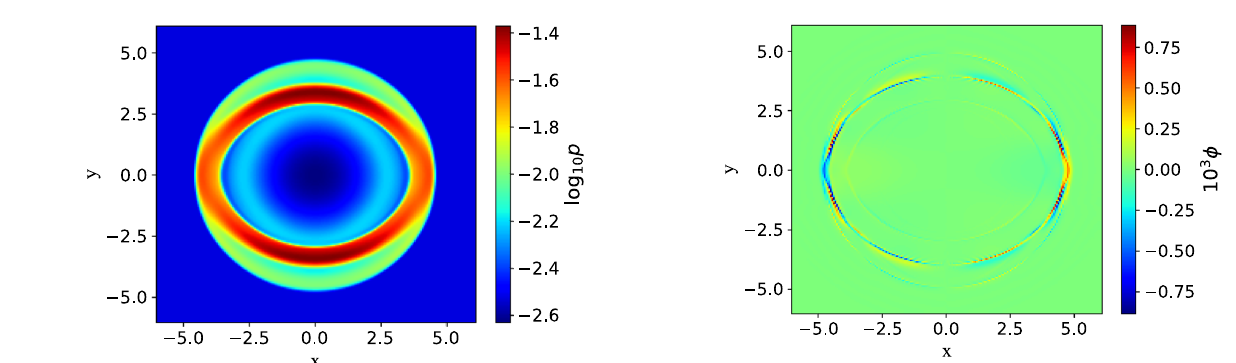
Fig. 6 The pressure of the fluid at t = 4 is shown in the 2D cylindrical explosion problem